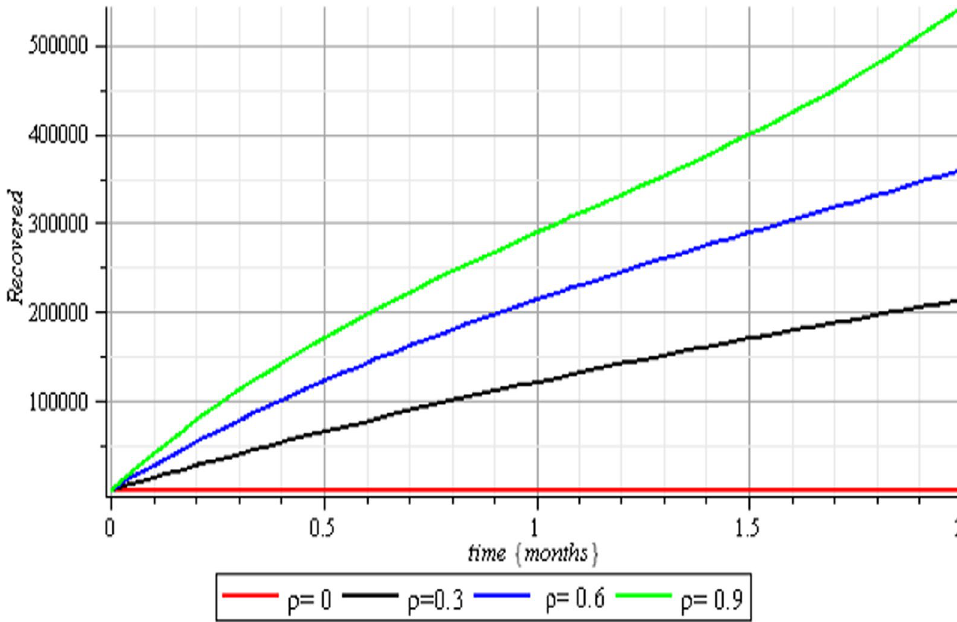
Fig. 10 Vaccination effects on the recovered class